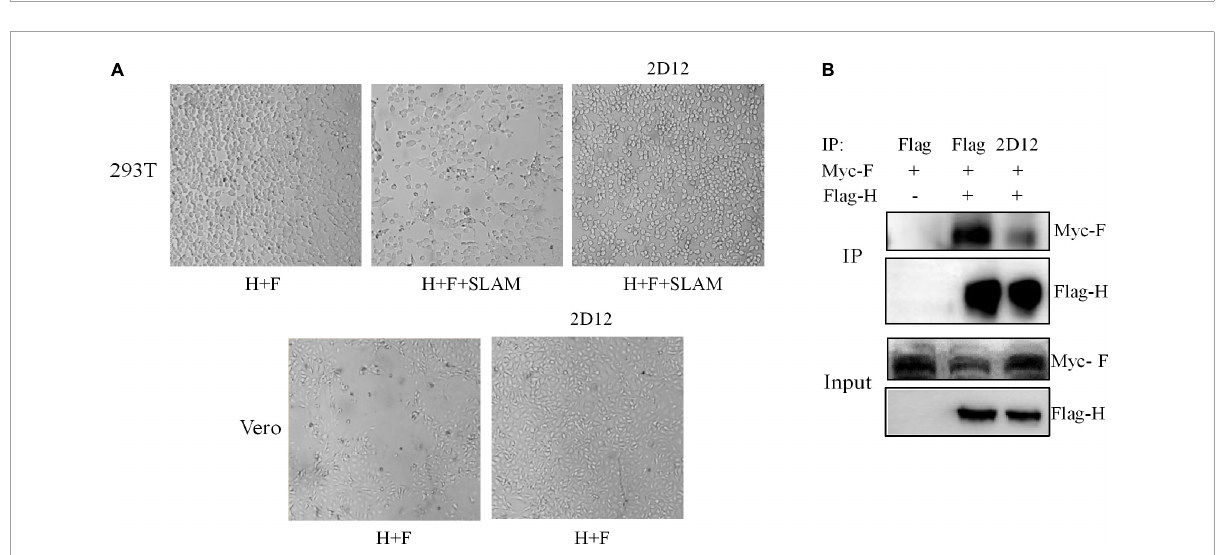
FIGURE6 Effect of mAb 2D12 on membrane fusion and interaction between H and F proteins. (A) Inhibition of H/F-mediated membrane fusion by mAb 2D12. Cell-to-cell fusion activity in Vero cells or 293T-dogSLAM cells triggered by co-expression of H and F of CDV 851 strain, in the presence (+) of absence (–) of mAb 2D12. Representative fields of view of cell-cell fusion induced 48 h post-transfection are shown. (B) Identification of the effect of mAb 2D12 on the interaction between H and F proteins by Co-IP assay. The Flag-H and Myc-F proteins of CDV 851 strain respectively expressed in 293T cells were immunoprecipitated with either mAb 2D12 or anti-Flag antibody, the precipitated Flag-H material was labeled with an anti-Flag antibody, and the coprecipitated Myc-F protein was detected with an anti-Myc